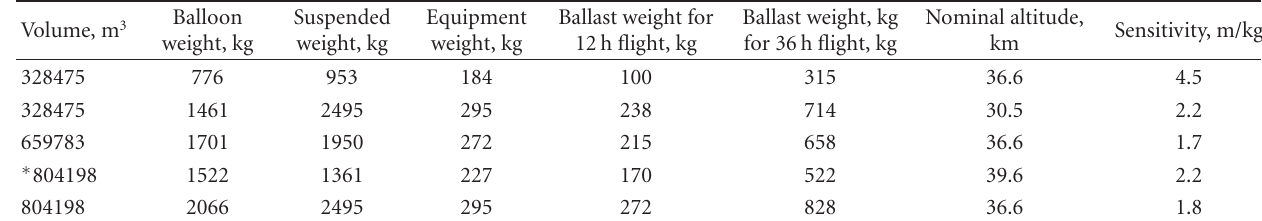
Table 6: NASA standard balloon